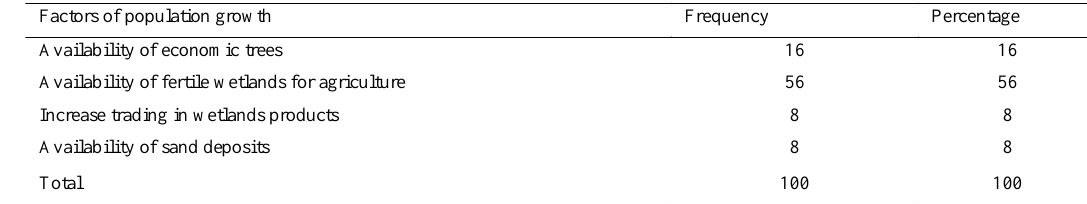
Table 1: Factors responsible for sudden population change in the study area (Adeleke, 2017) Factors of population growth